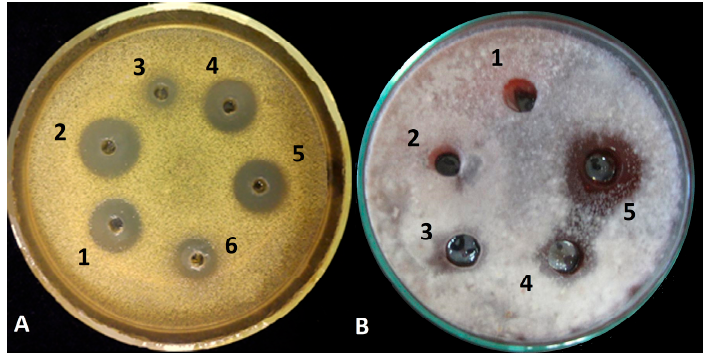
Figure 2. Biological activity assay of crude extracts from Trichoderma species against ( A ) Micrococcus luteus ; 1, 2, 4 and 5: Trichoderma asperellum IRAN 3062C (604.28 µg mL − 1 ), 3 and 6: Trichoderma longibrachiatum IRAN 3067C (230.1 µg mL − 1 ) and ( B ) Alternaria solani ; 1: methanol as control, 2: 10, 3: 50, 4: 100, 5: 200 µg mL − 1 of peptaibol extract from T. asperellum IRAN 3062C.